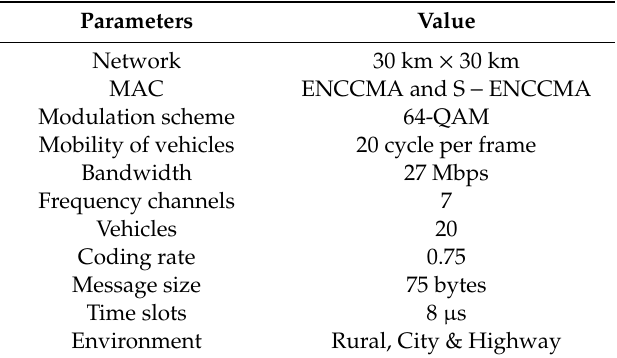
Table 3. Parameters. MAC: Medium Access Control.